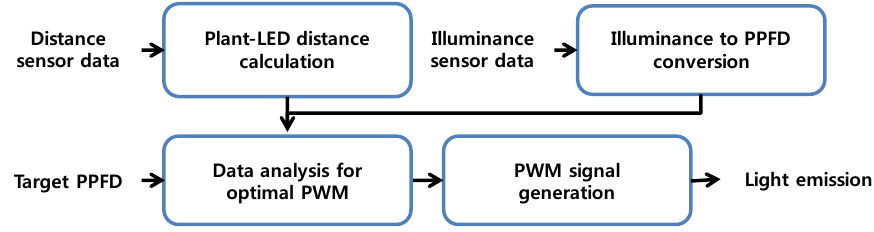
Figure 3. The proposed adaptive LED control method.